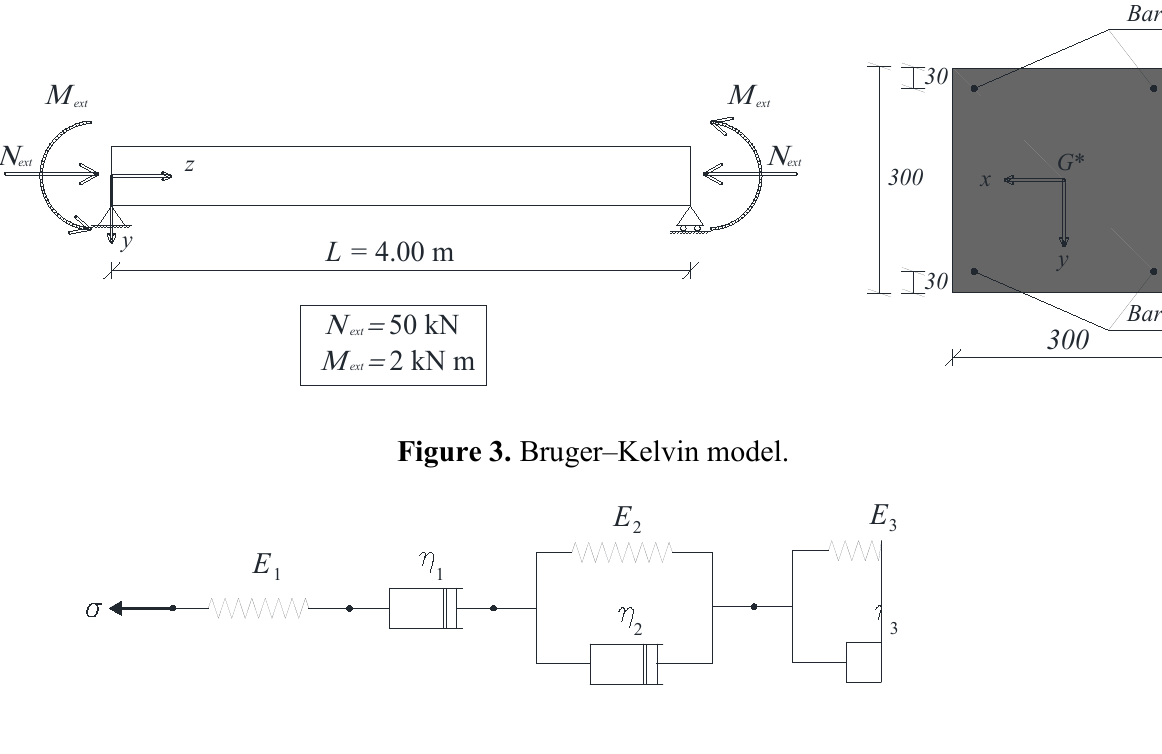
Figure 2. Reinforced polymer concrete beam (cross-sectional dimensions in mm).